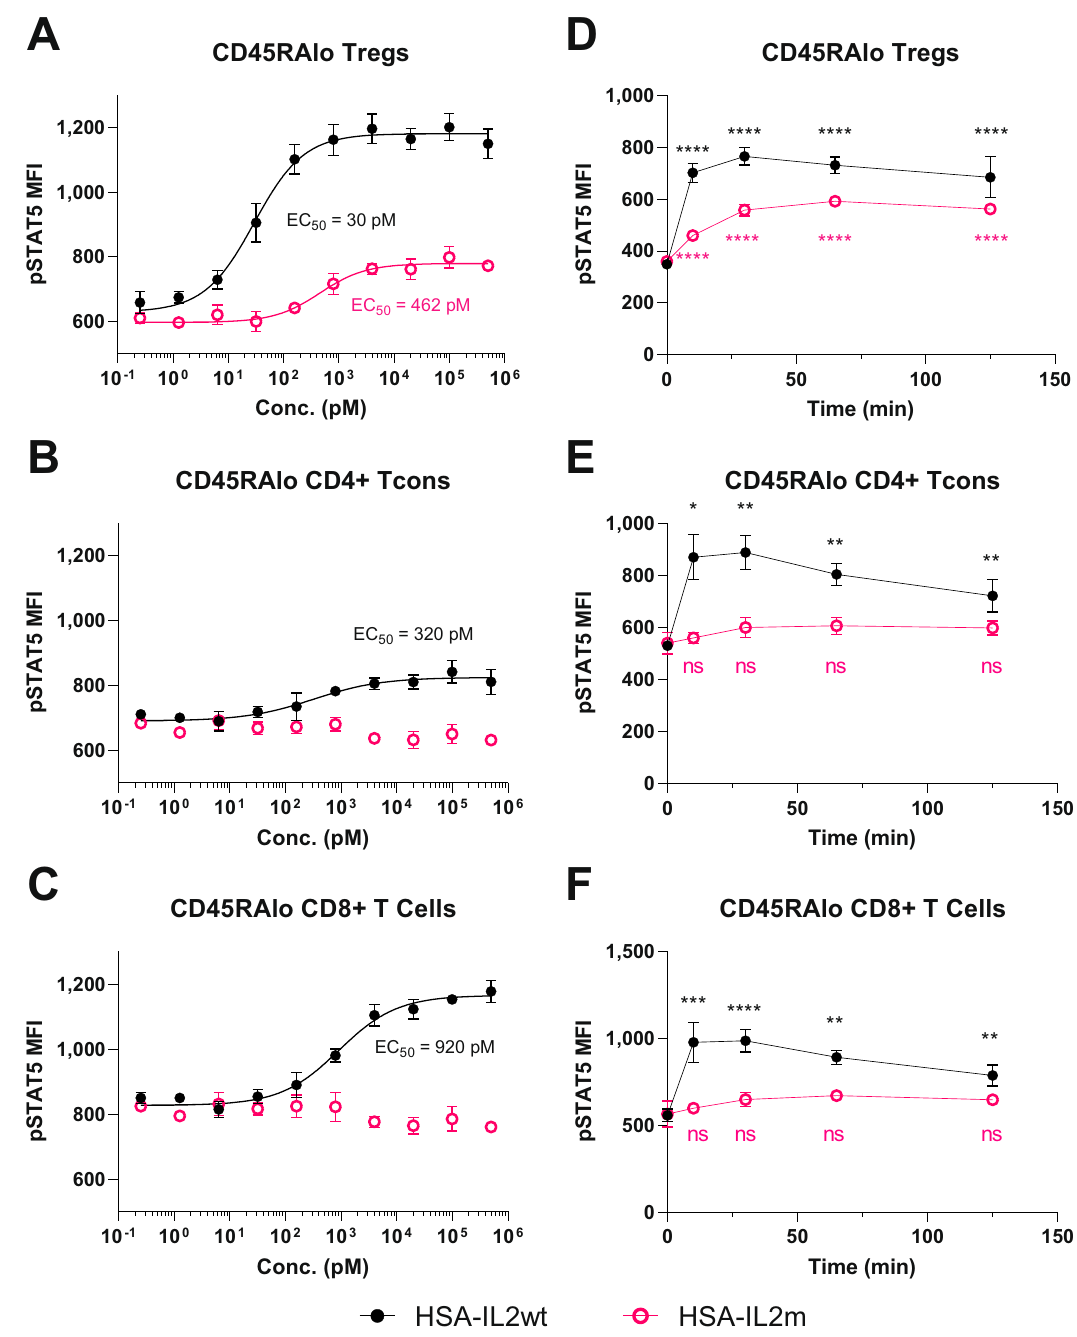
Fig. 1 Comparison of STAT5 phosphorylation in various human T cells subsets after treatment with HSA-L2wt and HSA-IL2m. HSA-IL2wt and HSA- IL2m titrations on A memory Tregs, B memory CD4 + conventional T cells, and C memory CD8 + T cells after 30 min incubation. Kinetics of STAT5 phosphorylation with 10 nM of HSA-IL2wt and HSA-IL2m on D memory Tregs, E memory CD4 + conventional T cells, and F memory CD8 + T cells. Data are presented as mean ± s.d. EC50 are derived from log-logistic fi t. Statistical analysis from two-way ANOVA with Dunnet ’ s multiple comparison to baseline, two-sided ( p -value * < 0.05, ** < 0.01, *** < 0.001, **** < 1e − 4, ns = not signi fi cant, n = 4). Source data are provided as a Source Data fi